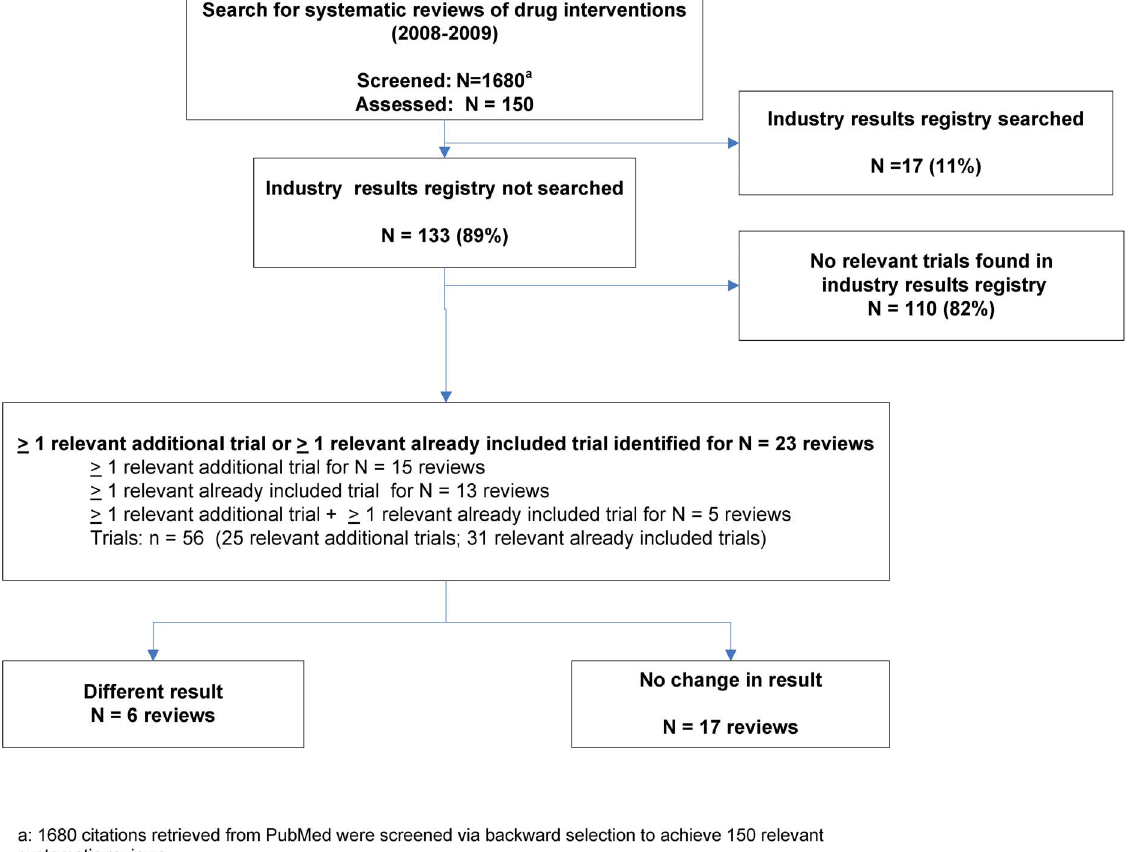
Figure 1. Flowchart of systematic reviews where a search in industry results registries led to a change in results.